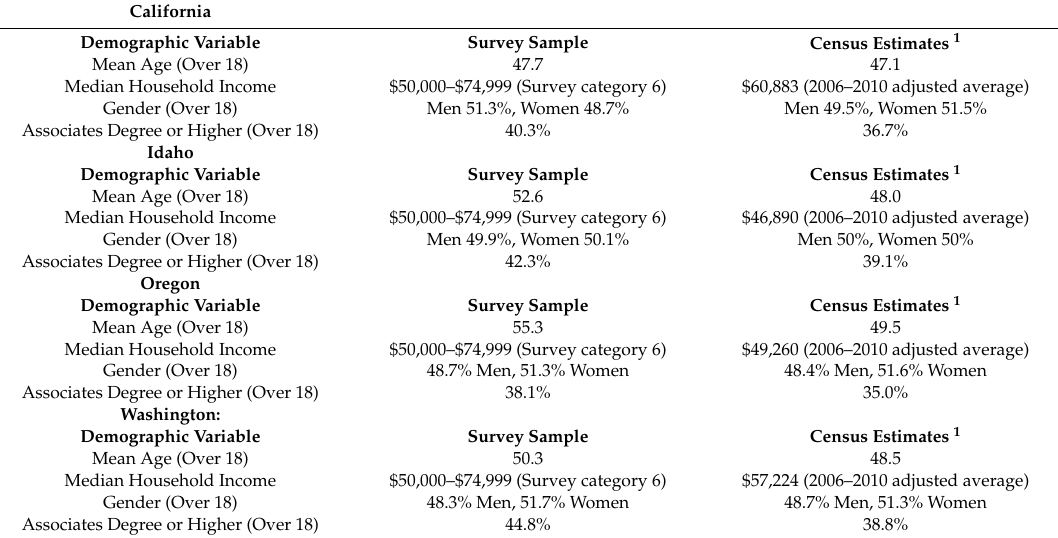
Table 2. Survey Response